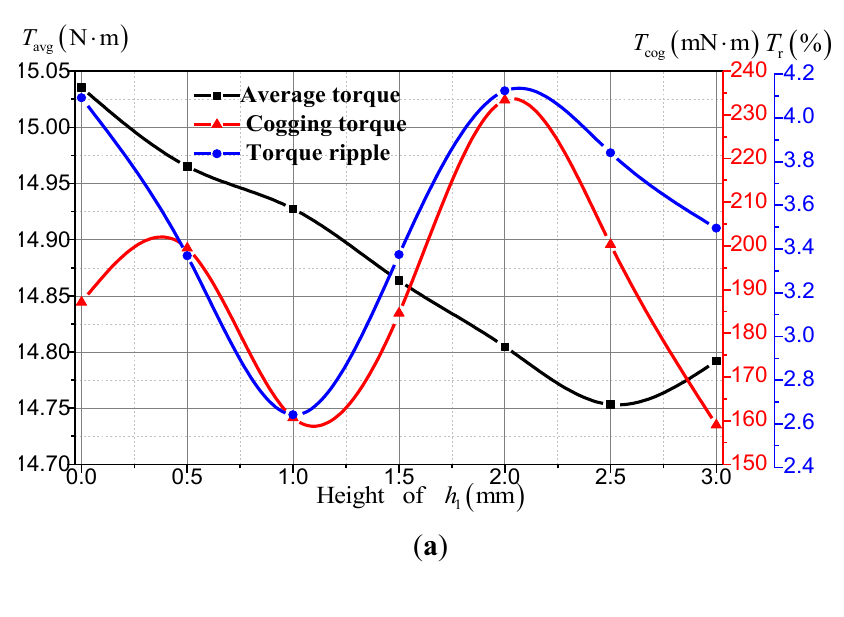
Figure 6. Average torques, torque ripples, cogging torques according to: ( a ) the height of h 1 ; ( b ) the depth of L ; and ( c ) the width of h 2